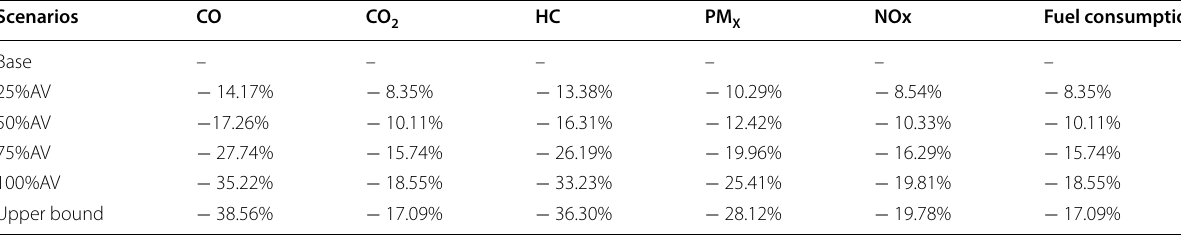
Table 3 The percentage reduction in emissions in comparison with the base model Scenarios